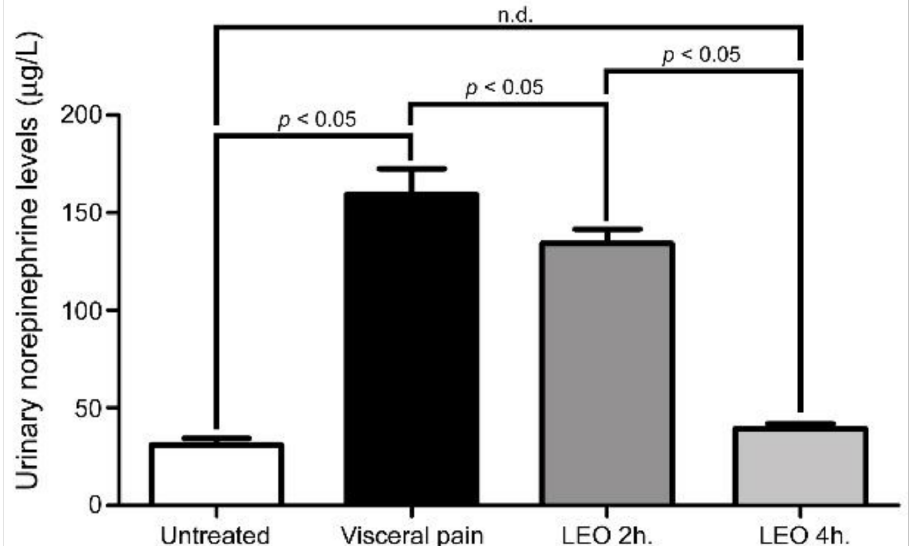
Figure 8. Histogram shows the urinary level of NE obtained from the untreated, visceral pain, and OS groups receiving LEO for 2 h and 4 h. Note that the urinary level of NE was drastically increased following the induction of visceral pain. However, in the animals subjected to visceral pain and receiving LEO, the urinary level of NE was effectively decreased to the value similar to that of untreated group. n.d. = no significant